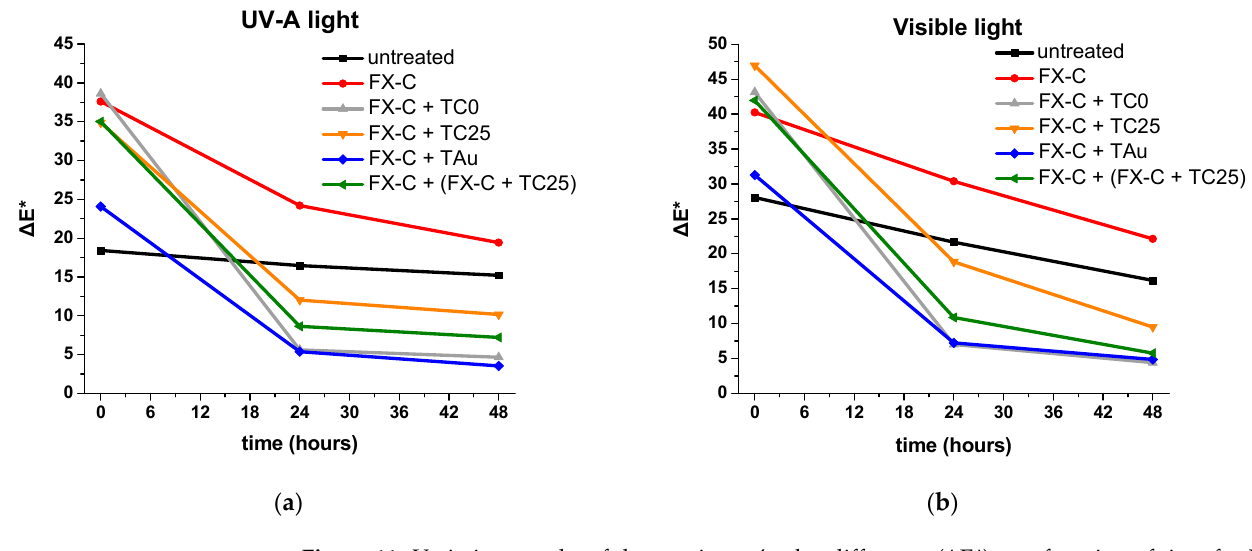
Figure 11. Variation graphs of the specimens’ color difference ( Δ E*) as a function of time for MB degradation under ( a ) UV-A and ( b ) simulated solar light irradiation. Table 2. Comparison of the specimens’ color difference ( ∆ E*) as a function of time for MB degradation under different radiation